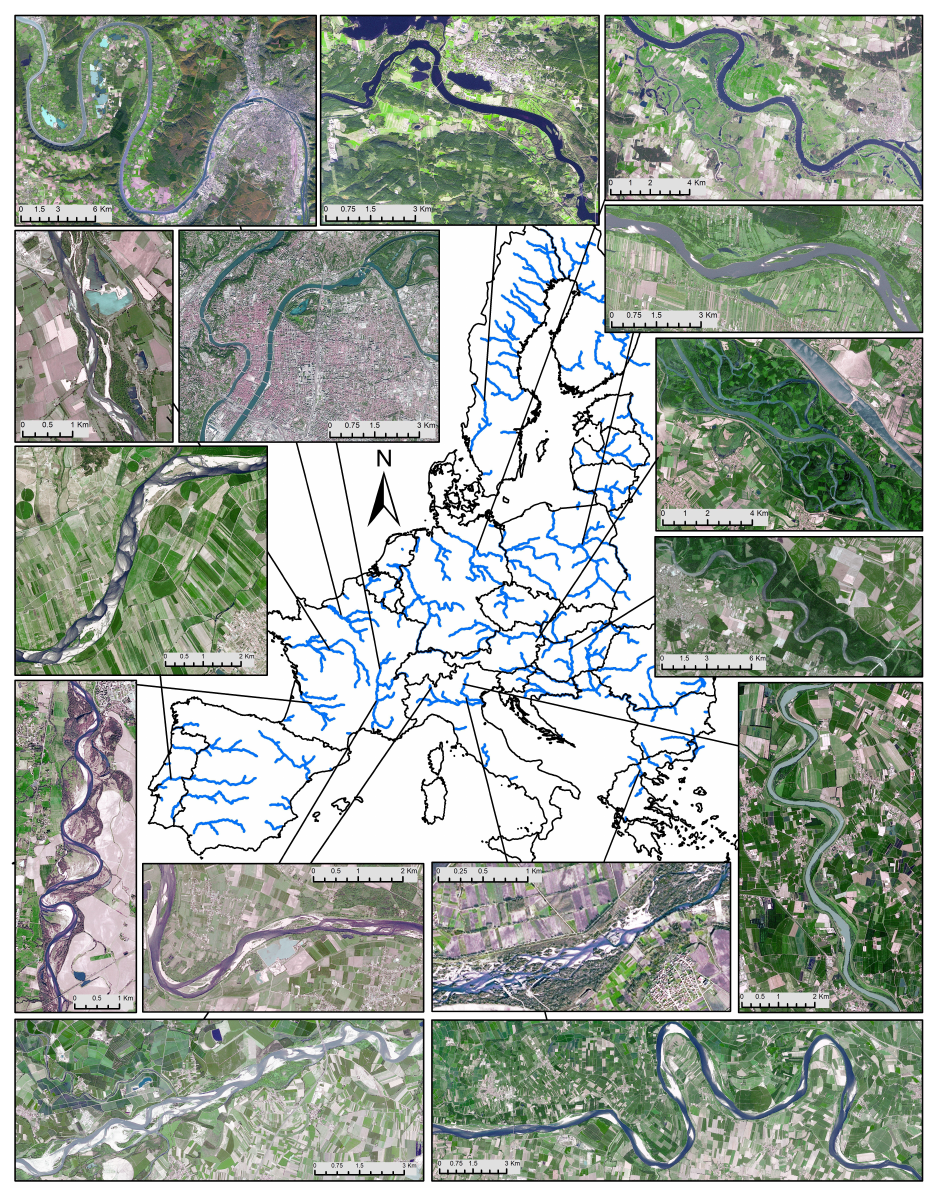
Figure 3. Some examples of the variable river types and forms analyzed in this